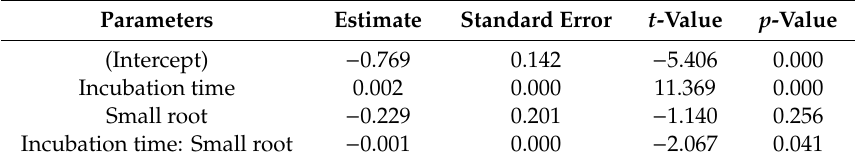
Table 1. Comparison of percentage of mass loss (logit transformed) from twigs and small roots of Parashorea chinensis Wang Hsie during decomposition monitored in a tropical rain forest in Mengla county, Xishuangbanna, China over a period of 1093 days. Percentage mass loss (logit transformed) was modeled as function of incubation time (number of days), sample type (twigs and small root), and two-way interaction. The intercept includes the baseline level of sample type (twig).